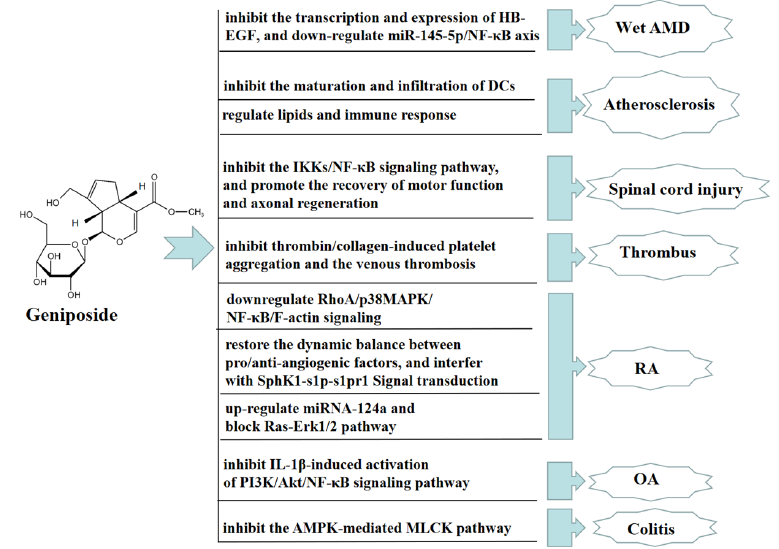
Figure 8. Other therapeutic effects of